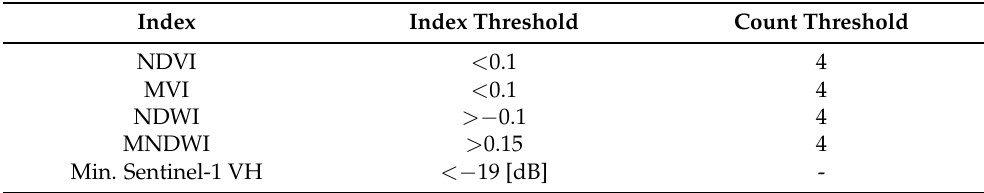
Table 1. Optimal thresholds identified for refining the mangrove extent for 2018. The index thresholds were applied to each scene to identify non-mangrove pixels. The count threshold was used to threshold the number of times a pixel has crossed the threshold combining the results from the individual scenes to create a single mask for each index. Acronym definitions: normalised difference vegetation index (NDVI), normalised difference water index (NDWI), mangrove vegetation index (MVI), Sentinel-1 vertical–horizontal (VH)